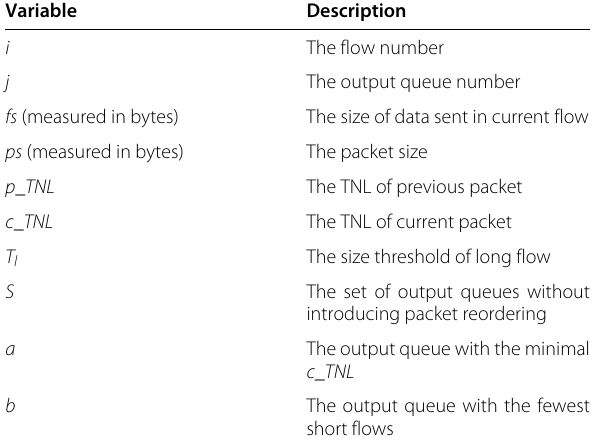
Table 2 The descriptions of variables in TR